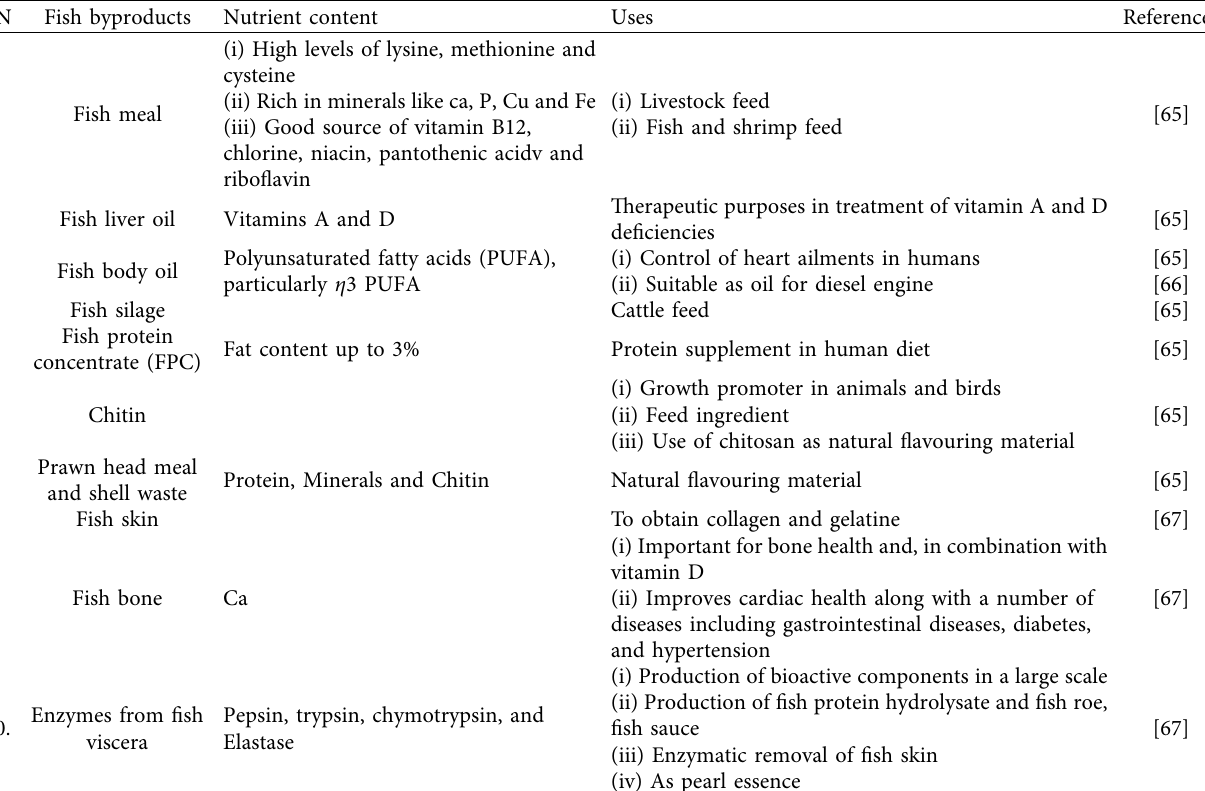
Source: [56]. Table 12: Uses derived from fish byproducts along with the nutrient obtained from them. SN Fish byproducts Nutrient content